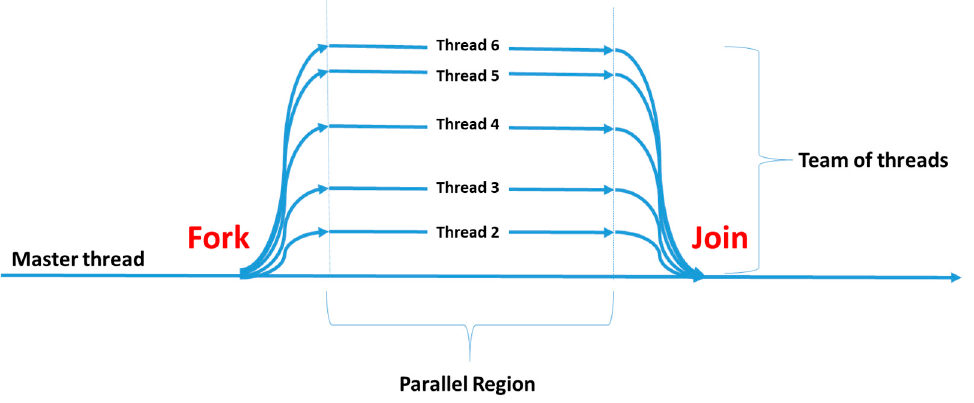
Figure 5. A sketch of the fork-join model.